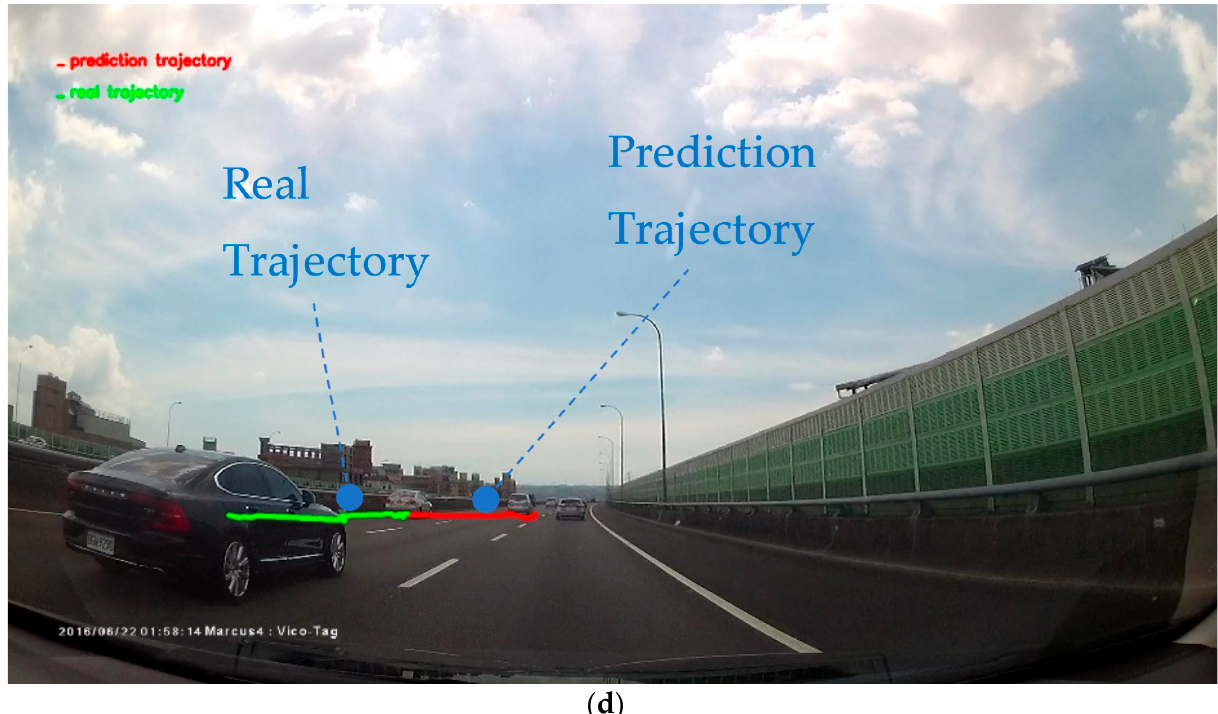
Figure 23. The car trajectory prediction results. We demonstrated the results in four rows: ( a ) and ( c ) real trajectory, ( b ) and ( d ) compare real trajectory and the trajectory predicted by our model. The green line is the real trajectory of the car, while the red line is the future trajectory predicted by our model.